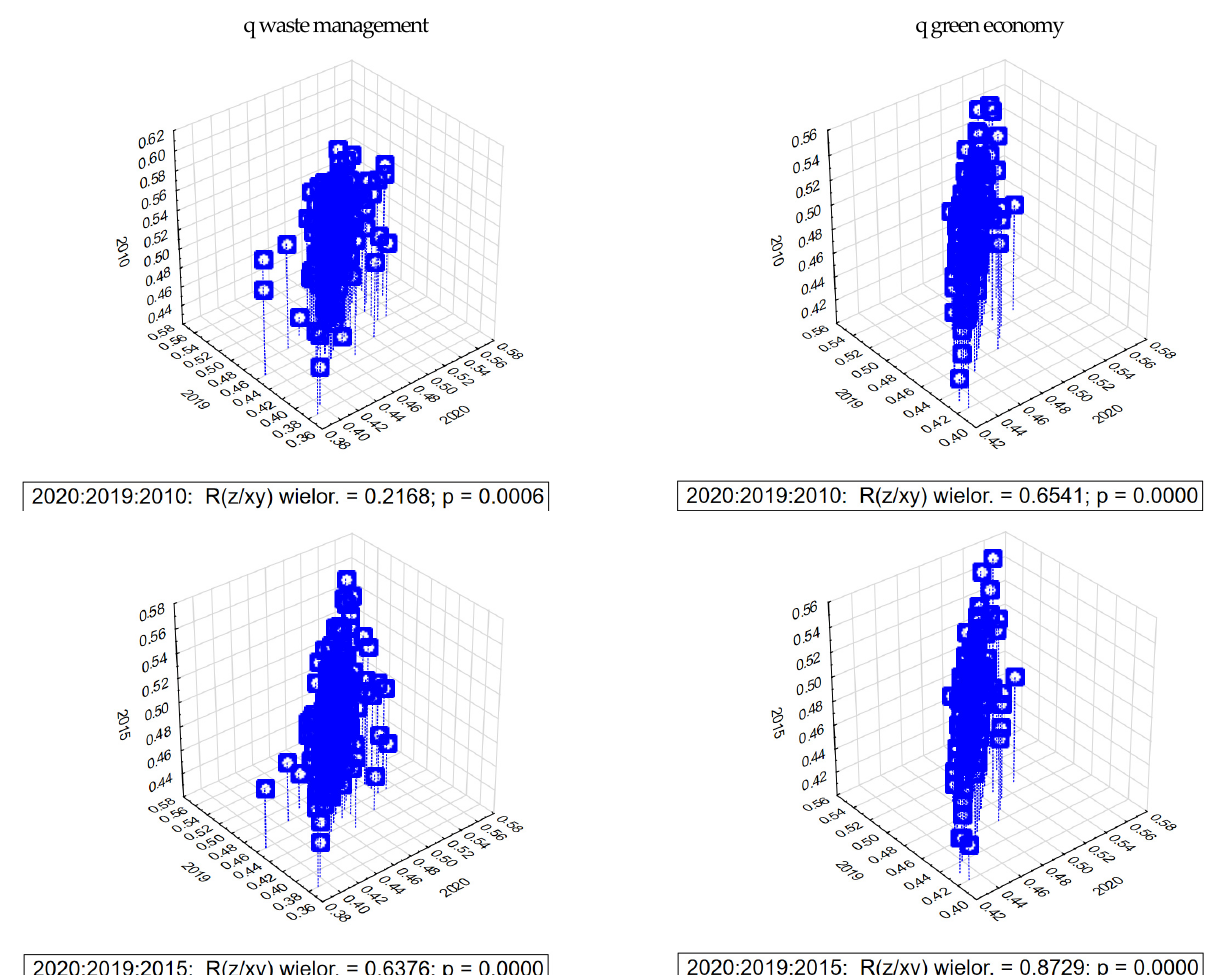
Figure 8. Interdependence of the synthetic measure of waste management and green economy of districts in relation to the years 2020-2019-2015 and 2020-2019-2010. Source: own elaboration based on BDL GUS data.